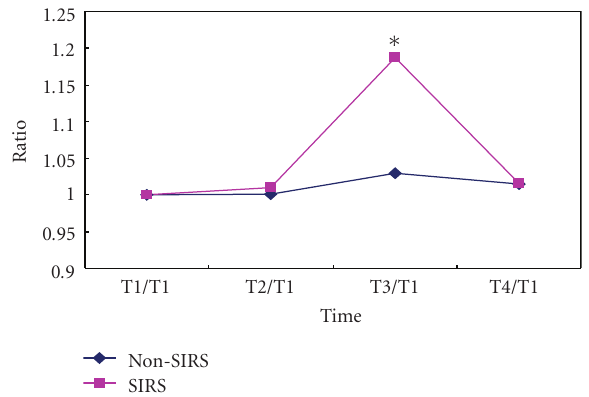
Figure 7: Increase of serum IL-8. Median (Q) (in SIRS group, n = 12; in non-SIRS group, n = 15); ∗ P < . 05, compared with